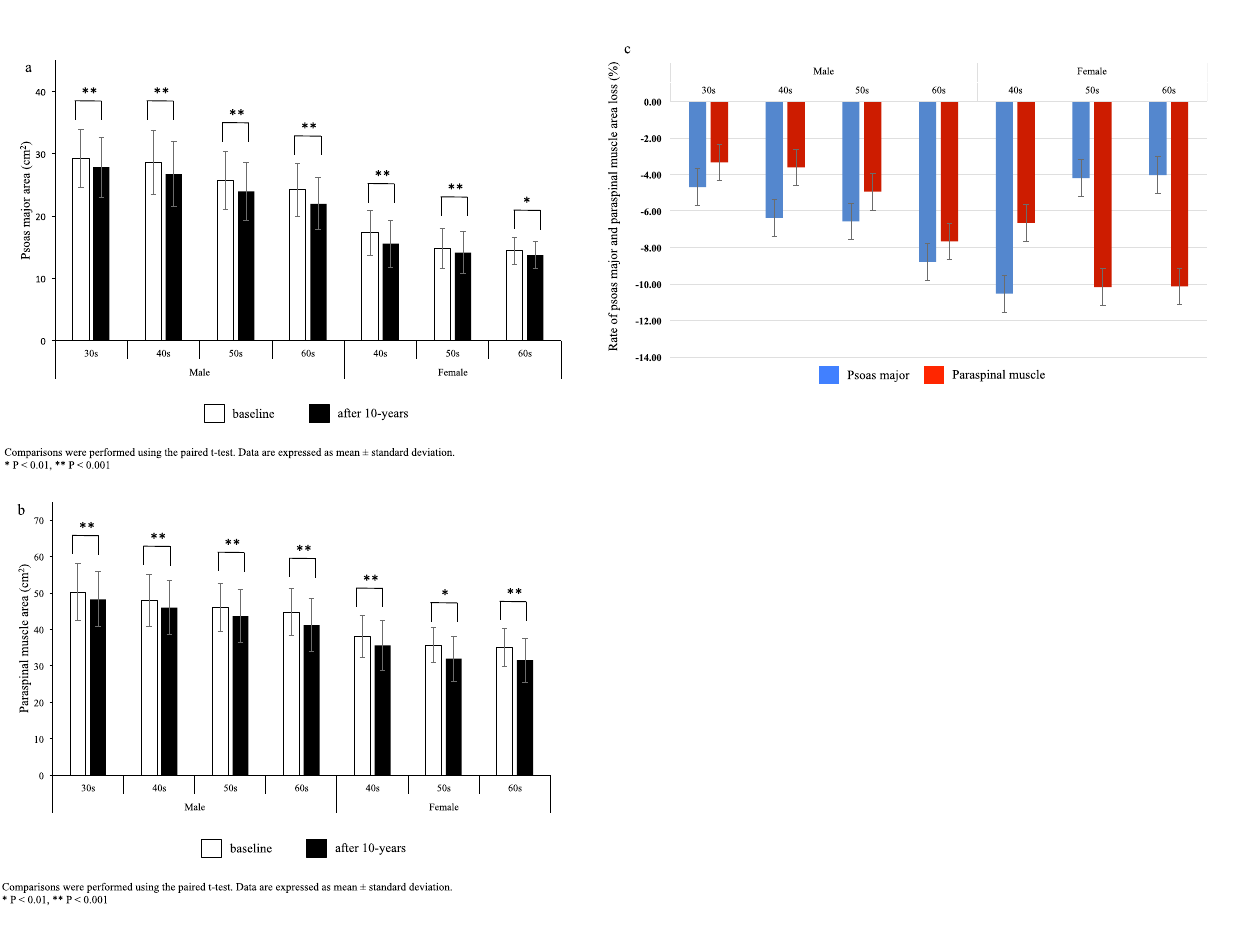
Figure 2. Differences in psoas major and paraspinal muscle areas over a 10-year period. ( a ) Differences in psoas major muscle area over 10 years. ( b ) Differences in paraspinal muscle area over 10 years. ( c ) Rate of psoas major and paraspinal muscle areas loss over 10 years.